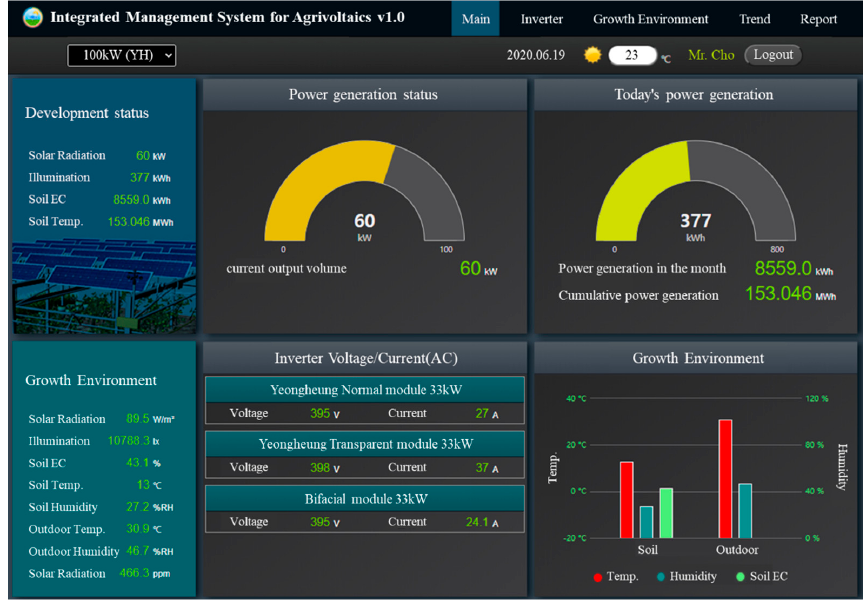
Figure 11. Integrated management system for agrivoltaics.